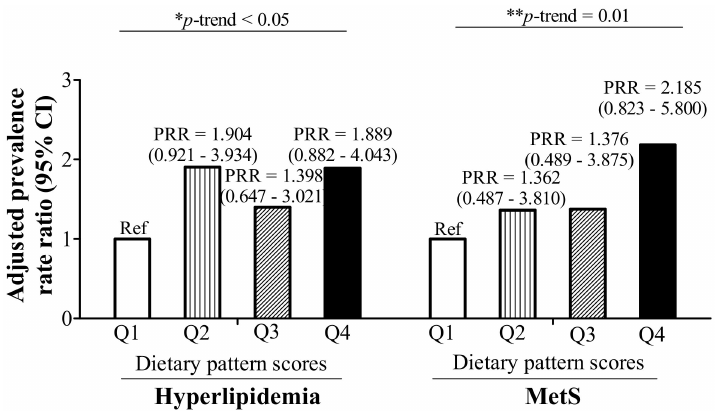
Figure 4. Prevalence rate ratio (PRR) and 95% confidence intervals of dietary pattern score quartile levels for hyperlipidemia and metabolic syndrome (MetS) adjusted for age, sex, and log-transformed body mass index (BMI). * p ≤ 0.05, ** p ≤